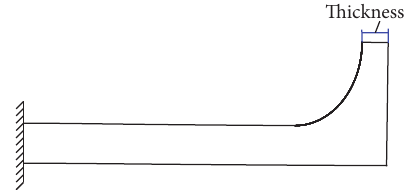
Figure 4: The thickness of the contact part in the elastic element.